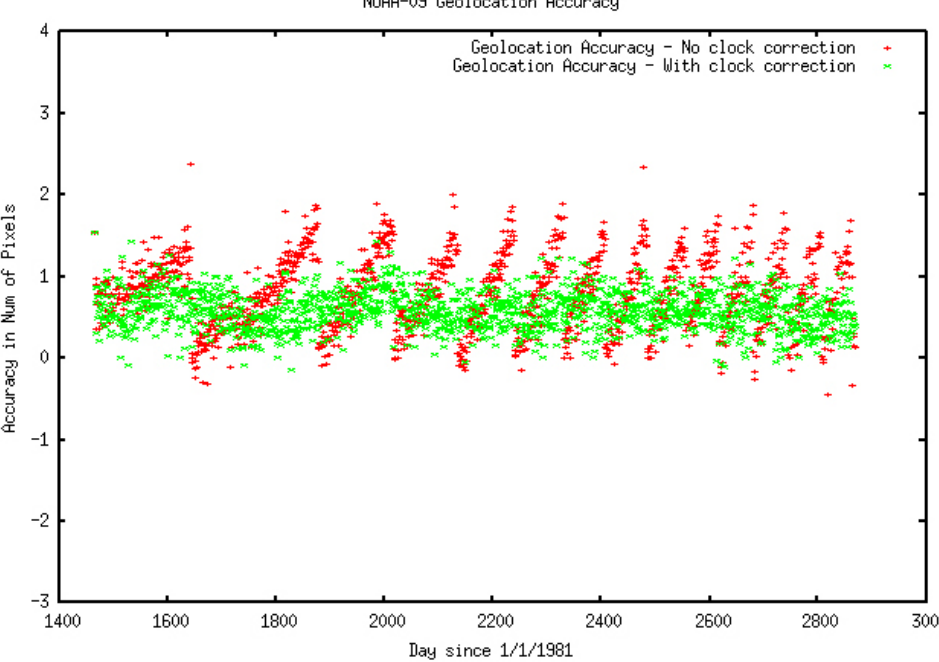
Figure 2. Accuracy assessment of the geolocation of AVHRR products using the coastal chips database (in fraction of pixels). Green is with clock correction, and red is without clock correction.